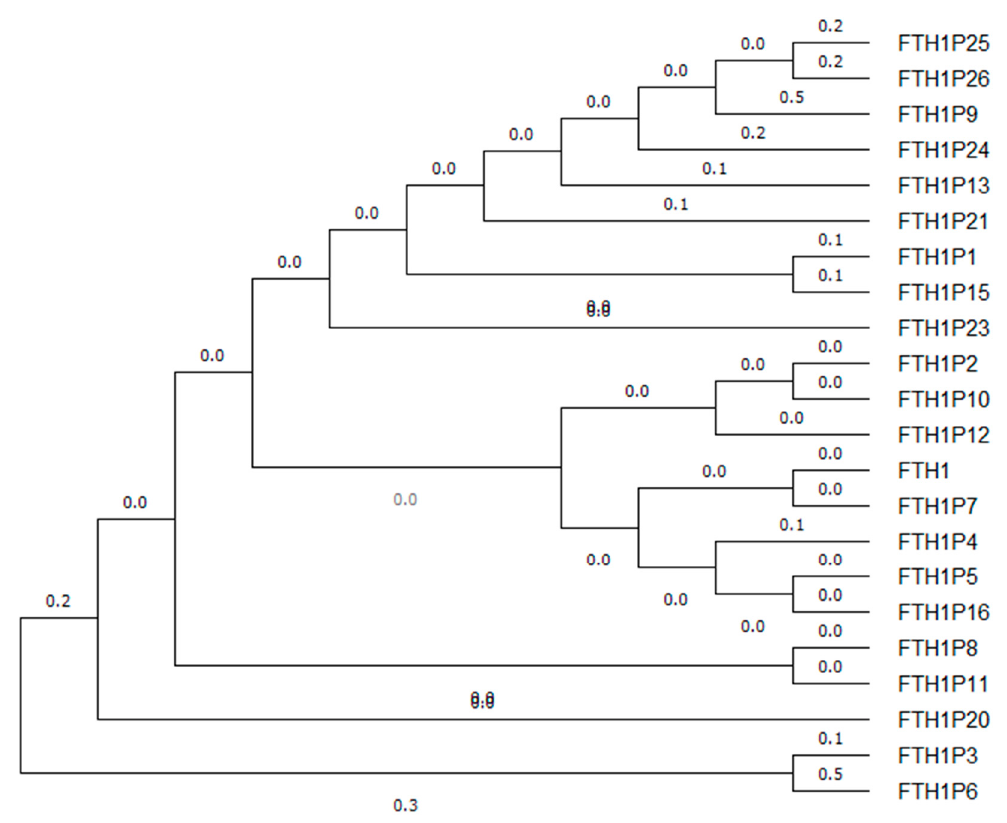
Figure 3. Evolutionary analysis of FTH1 family by using the Maximum Likelihood method [70] .